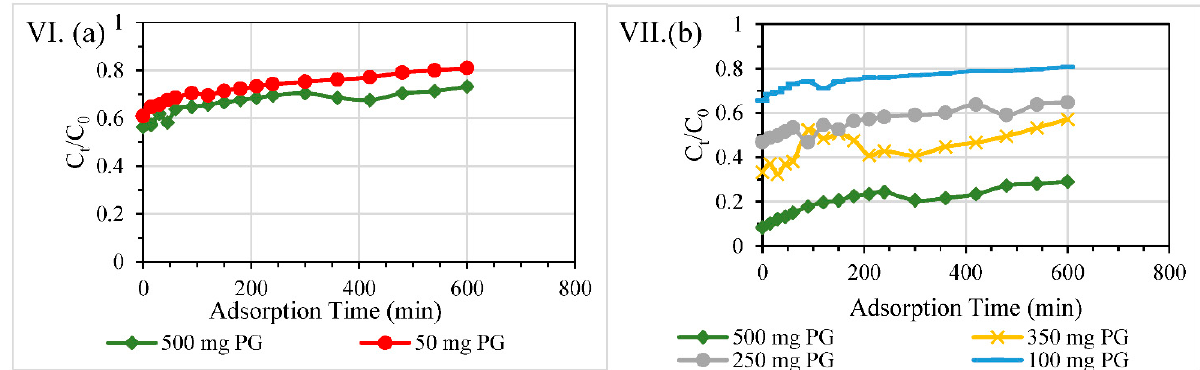
Figure 6. ( I ) ATL, ( II ) CBZ, ( III ) CIP, ( IV ) DCF, ( V ) GEM, ( VI ) IBP adsorption onto PG/SND (PG at 0.5% wt.) filter medium in different column sizes ( a ) 18 mm ID ( b ) 40 mm ID. Experimental conditions: ECs-contaminated DW influent adjusted at 10.5 mg/L of EC; room temperature at 22 ± 3 °C.